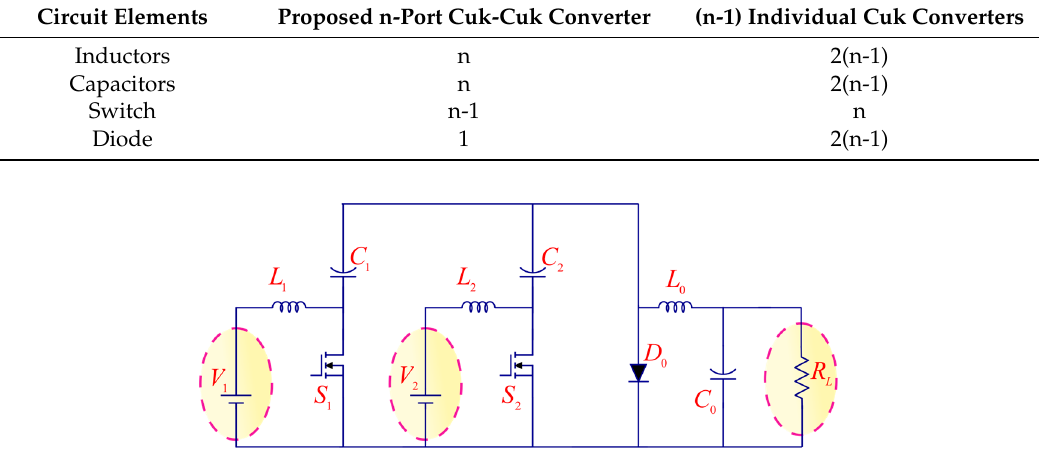
Figure 4. Proposed three-port converter.